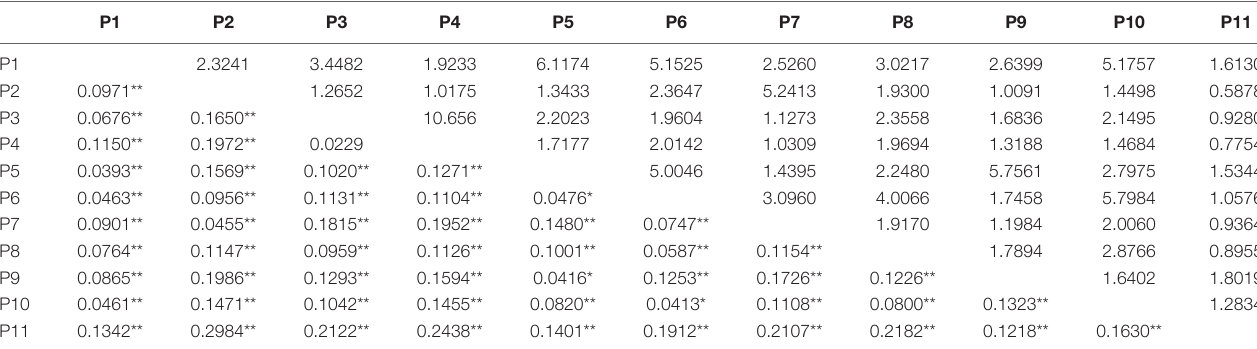
TABLE 5 | Matrix of pairwise F st (below diagonal) and N m values (above diagonal) among the 11 populations of Aphis aurantii based on concatenated